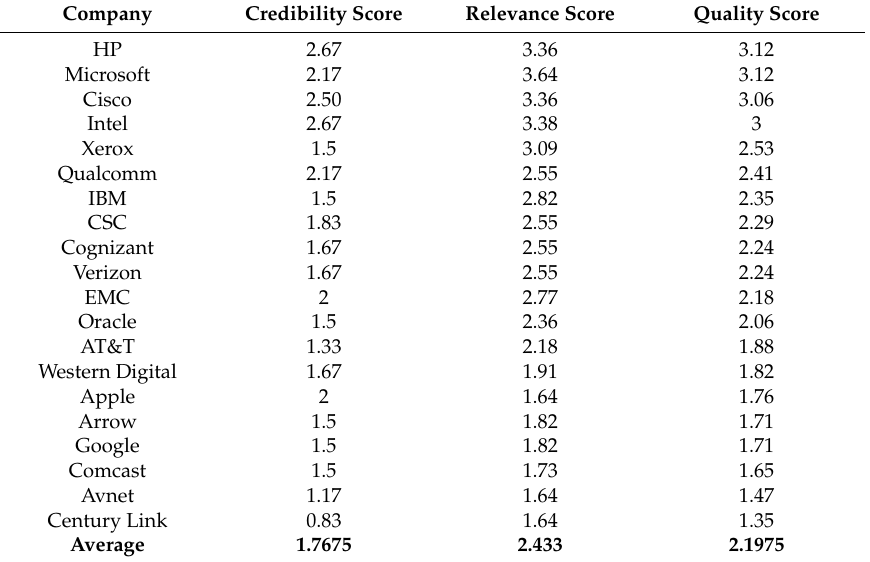
Table 6. The level of confidence of each strategy based on a 0 to 4 scale for the global level of confidence and on a 0–10 for the confidence score. (The lines in grey mean that the strategy reached the quality threshold we